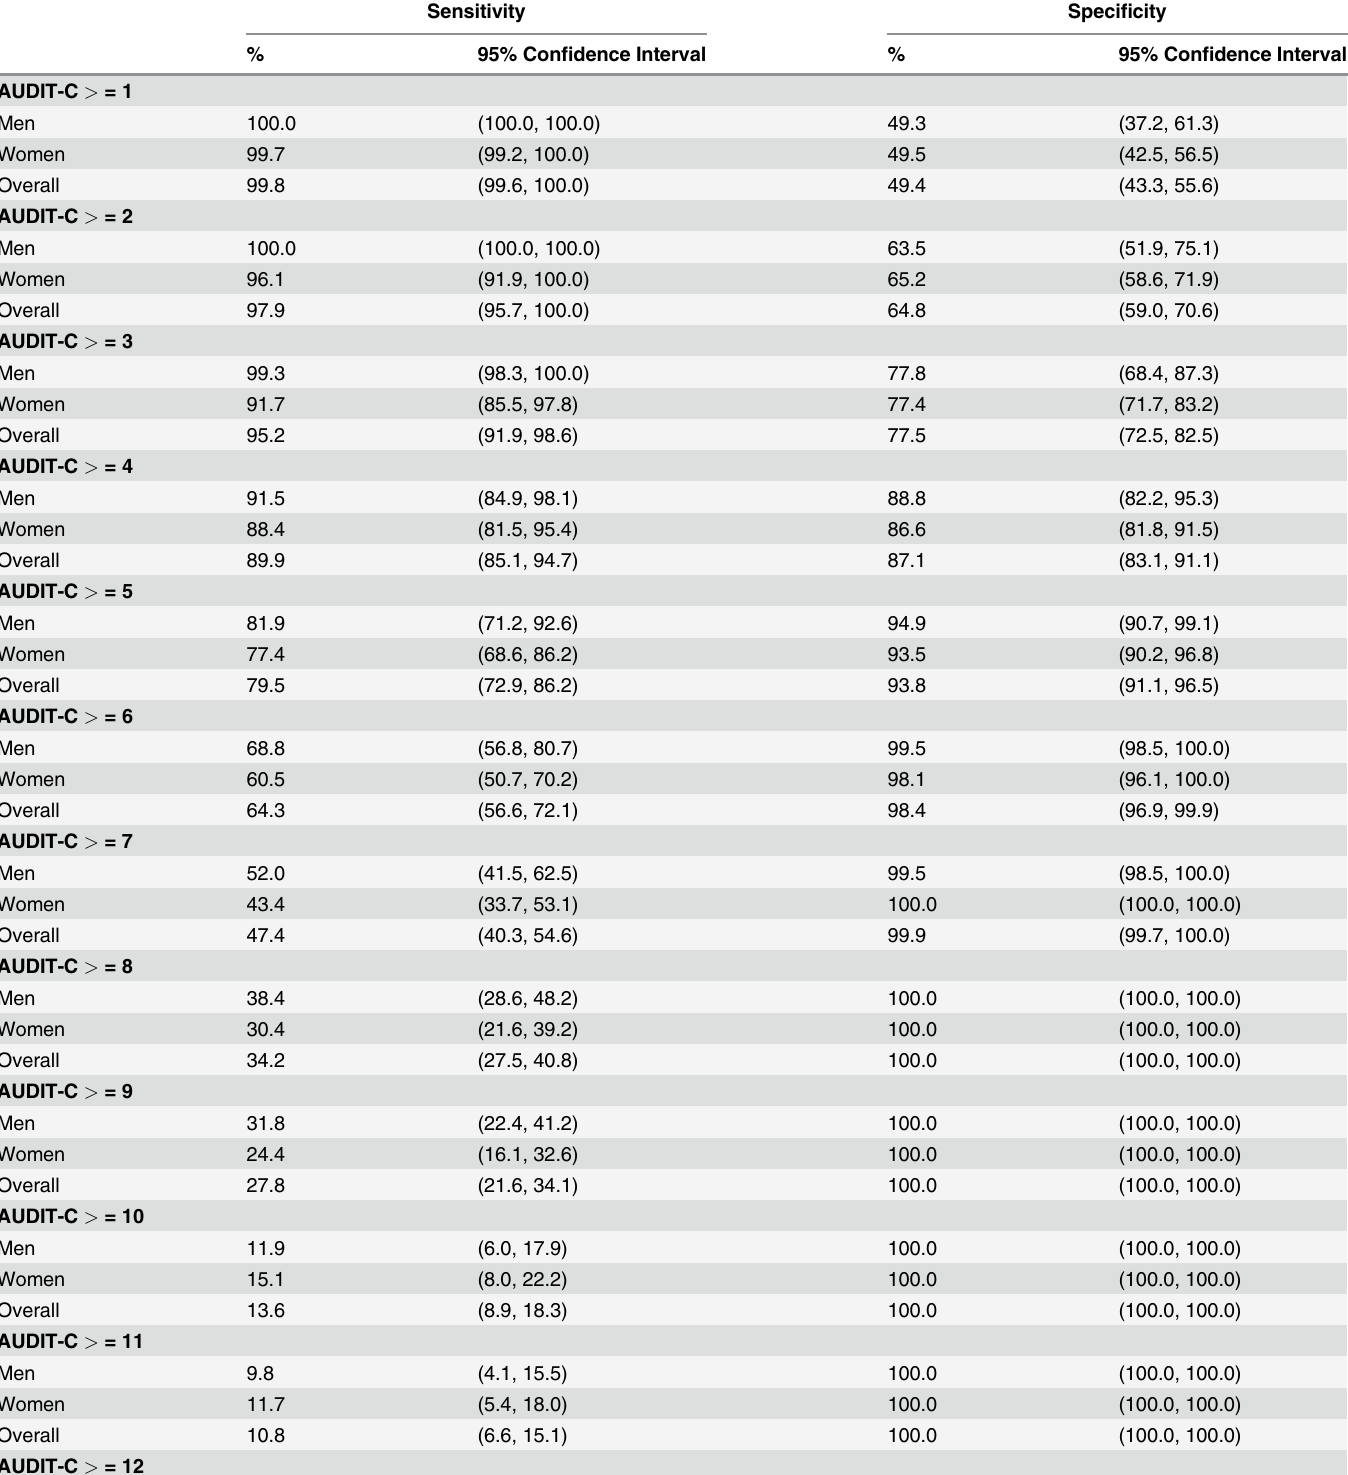
Table 3. Sensitivity and Speci fi city of Cut-offs for AUDIT-C to the full AUDIT *